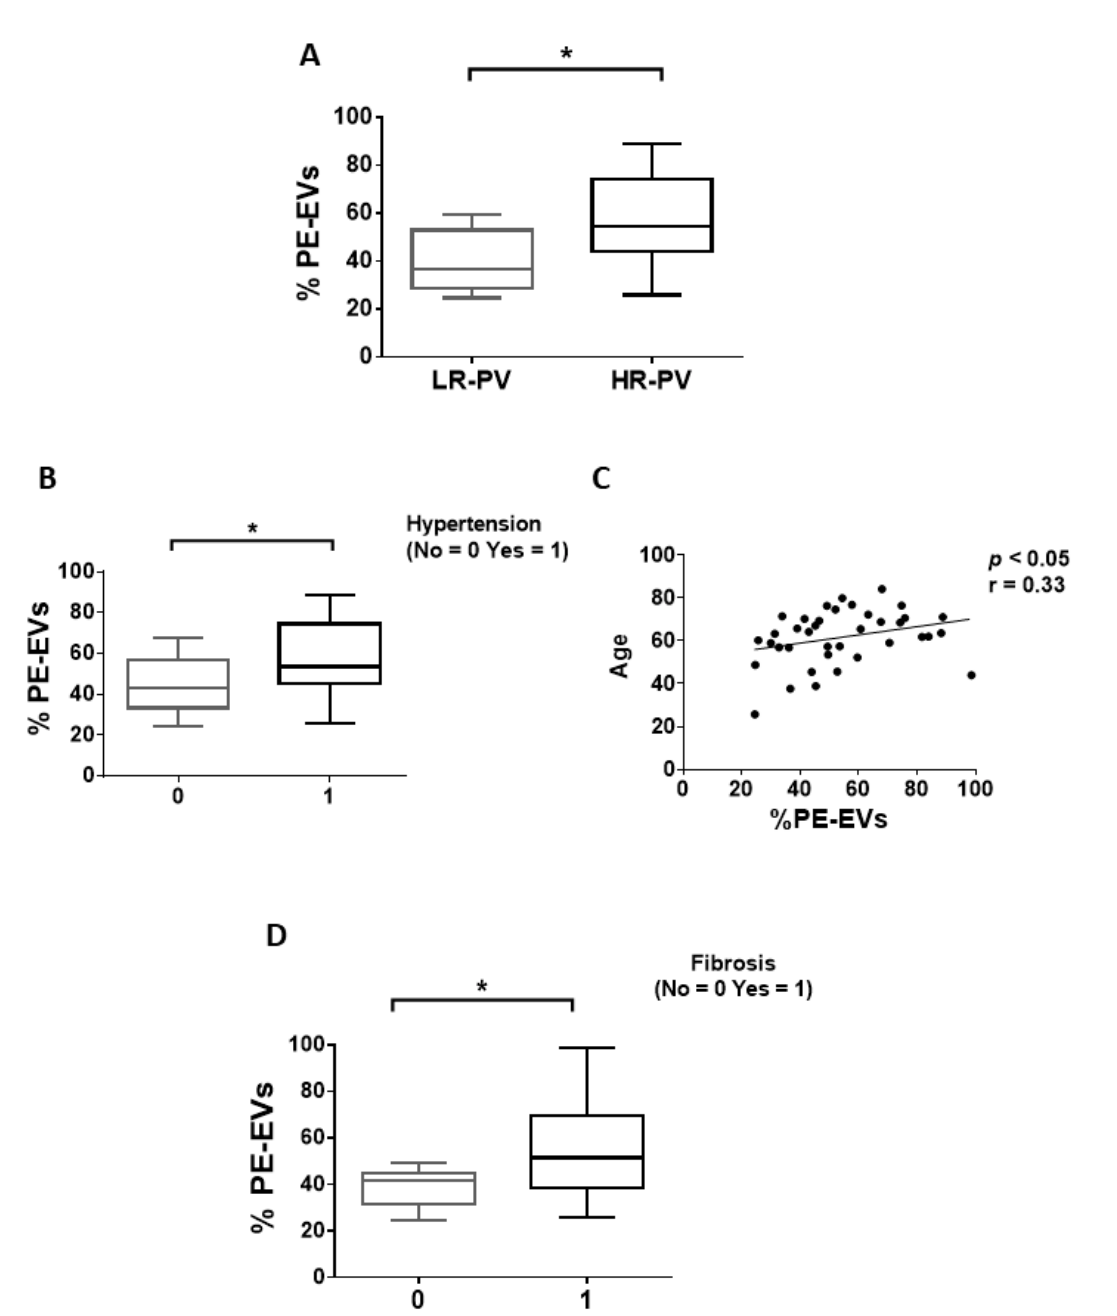
Figure 2. Proportion of circulating PE-EVs of PV patients. ( A ) Frequency of PE-EVs in PV patients with low (LR-PV; n = 11) vs. high (HR-PV; n = 27) risk. ( B ) Proportion of PE-EVs of PV patients with ( n = 24) or without ( n = 14) hypertension. ( C ) PE-EVs percentages of PV patients positively correlate with age (Spearman’s correlation test). ( D ) Frequency of PE-EVs in PV patients with ( n = 10) or without ( n = 28) marrow fibrosis. ( A , B , D ) Data are expressed as percentage of PE-EVs and presented as min to max with median (Mann–Whitney test; * p < 0.05).